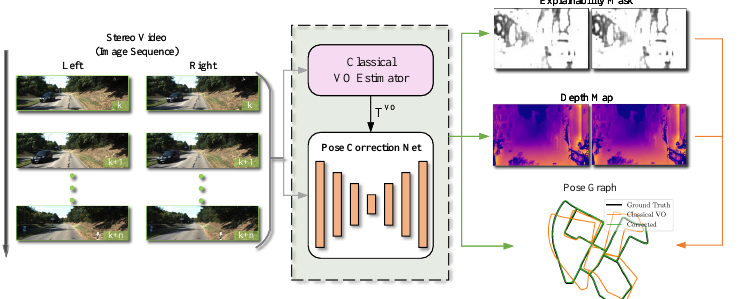
Figure 1. The testing framework of the proposed unsupervised stereo visual odometry pose correction network. It takes the prior pose ( T VO ) produced by classical stereo VO system (e.g., ORB-SLAM2 [19], DSO [6], and LSD-SLAM [5]) and stereo color images as input and produces pose correction, depth map, and explainability